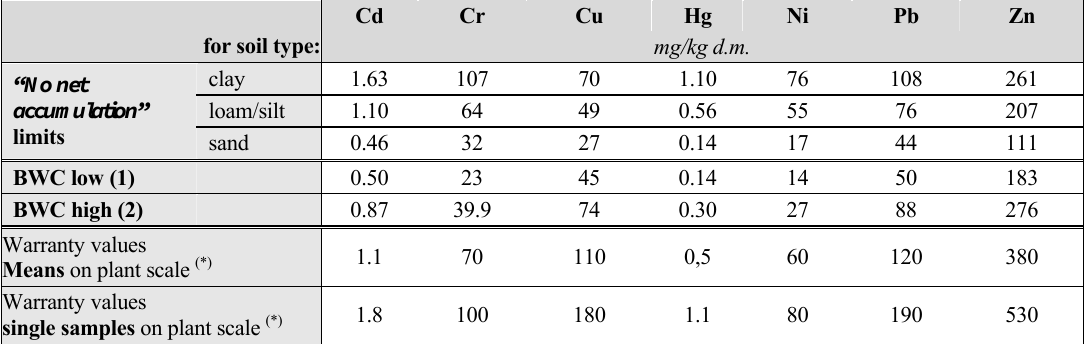
Calculated limit values for composts following Bannick et al. (2002 [FA9] ) in comparison to existing qualities in Europe and statistically “warranted” mean value and individual concentrations on facility level Cd Cr Cu Hg Ni Pb Zn for soil type: mg/kg d.m.